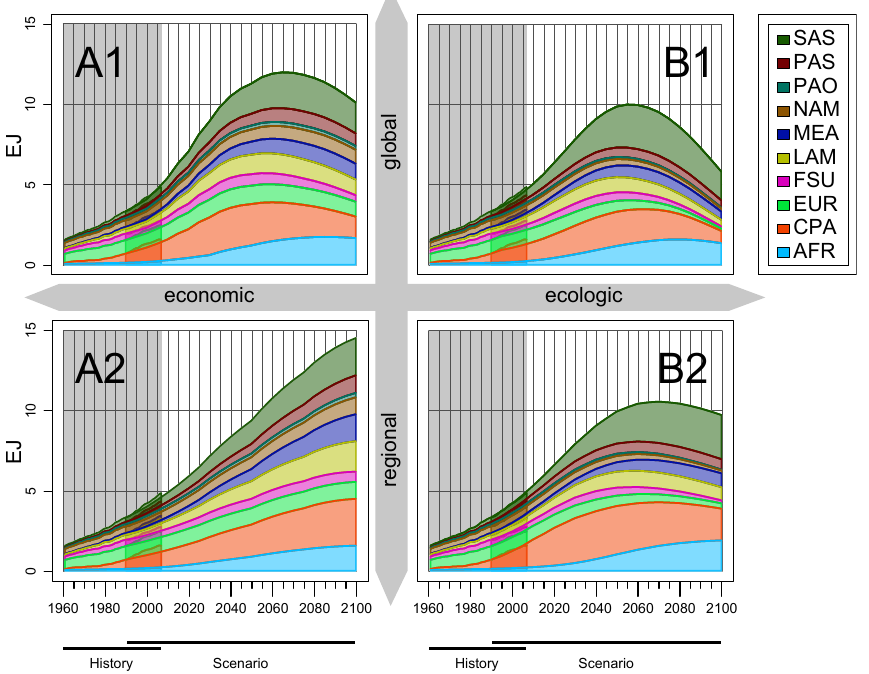
Fig. A3. Demand for energy from livestock products in the 10 MAgPIE world regions. History and future developments for the four SRES scenarios (Bodirsky et al.,